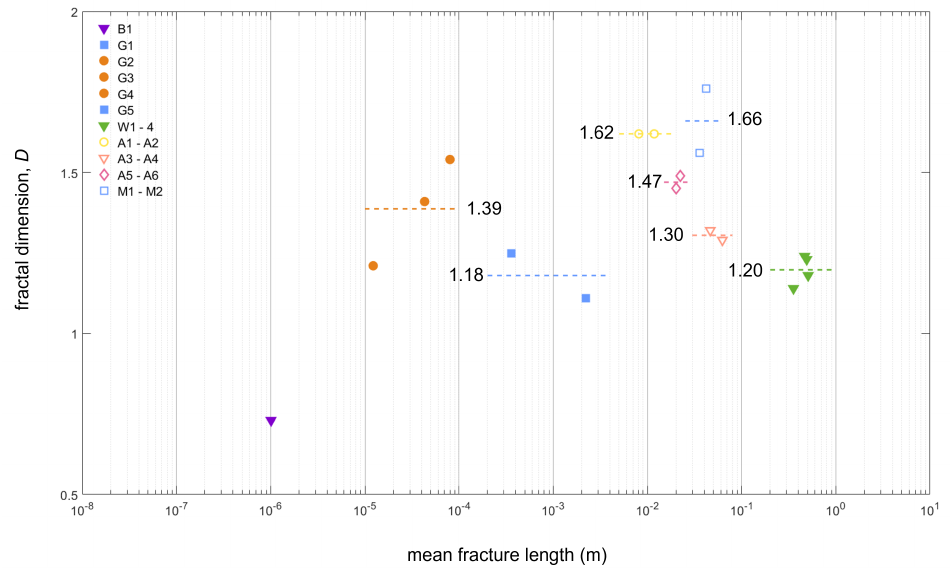
Figure 2. Fractal dimensions calculated for the image